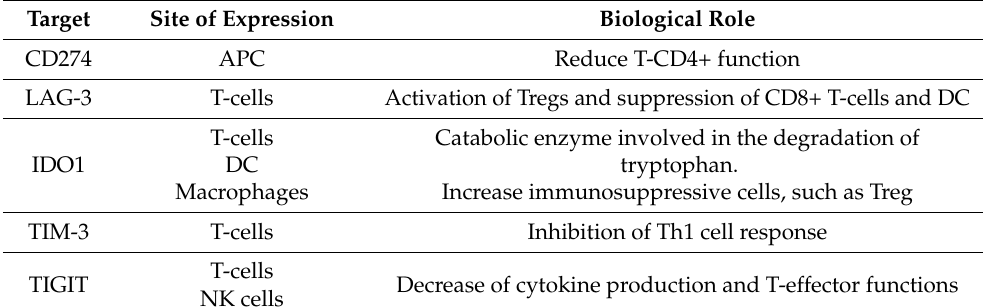
Table 2. Potential therapeutic targets in combination with